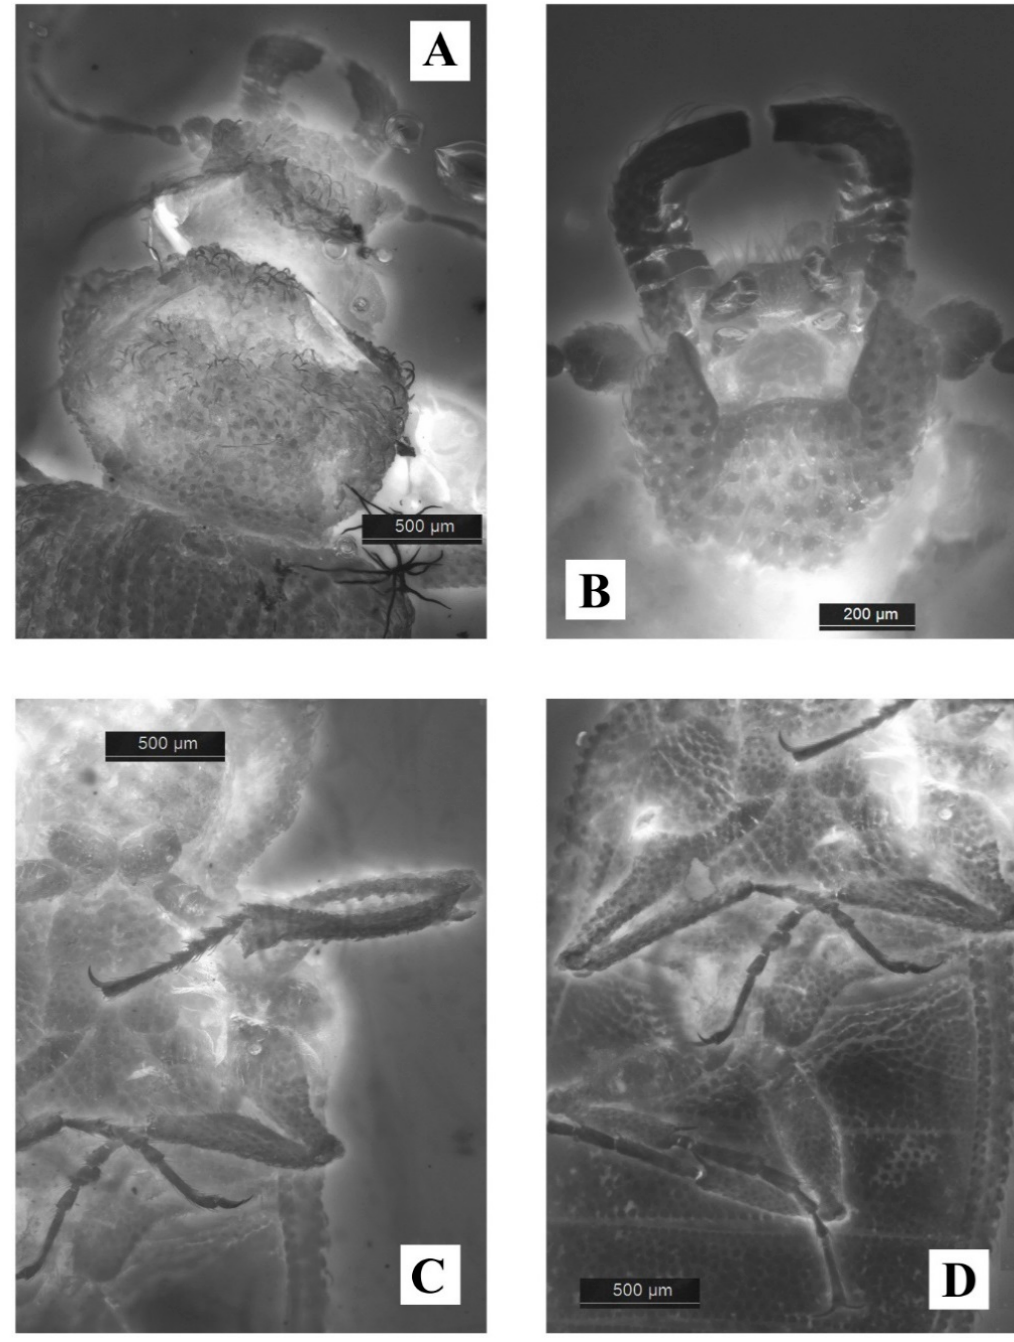
Figure 10. Ommatinae (Cupedidae): Clessidromma zengi sp. nov. , holotype ZIN Cuped 003 (Lower / Upper Cretaceous: Upper Albian / Lower Cenomanian; Myanmar, Kachin, Burmese amber): A —beetle, dorsal, B —same, ventral, C —anterior part of body, ventral; D —elytra, dorsal; fluorescent microscopy with filter set L5 for A and B, and also filter set N21 for C and E; length of inclusion 6.2 mm, scale for each picture provided; original.